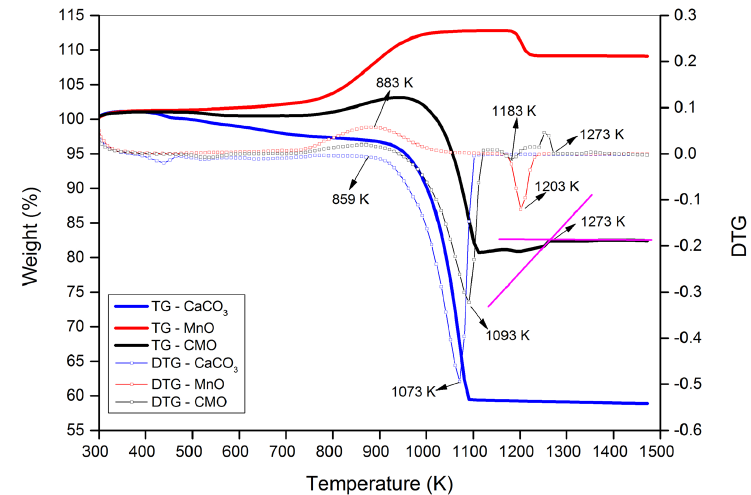
Figure 1. TG/DTG curves for raw precursors and CMO